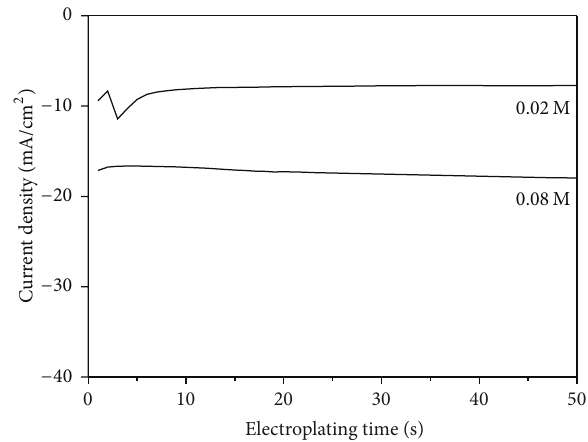
Figure 1: Potentiostatic current–time transients of the Fe–Cu films electrodeposited from the electrolytes with low and high Fe ion concentrations.